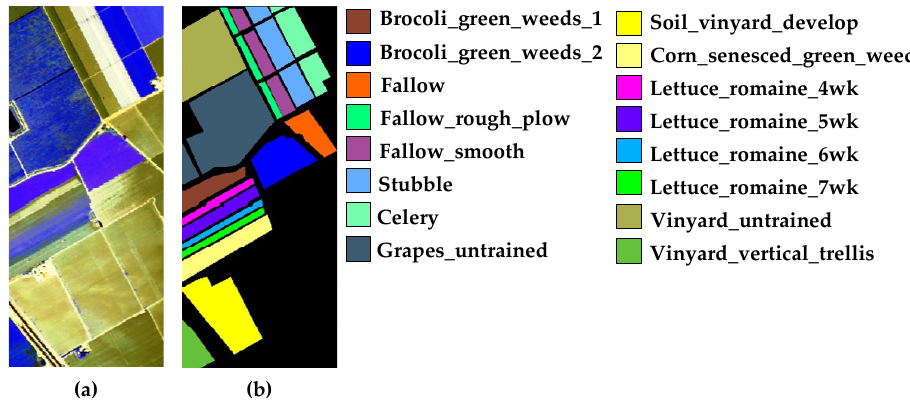
Figure 16. Salinas Scene: ( a ) false-color map; ( b ) ground-truth image.